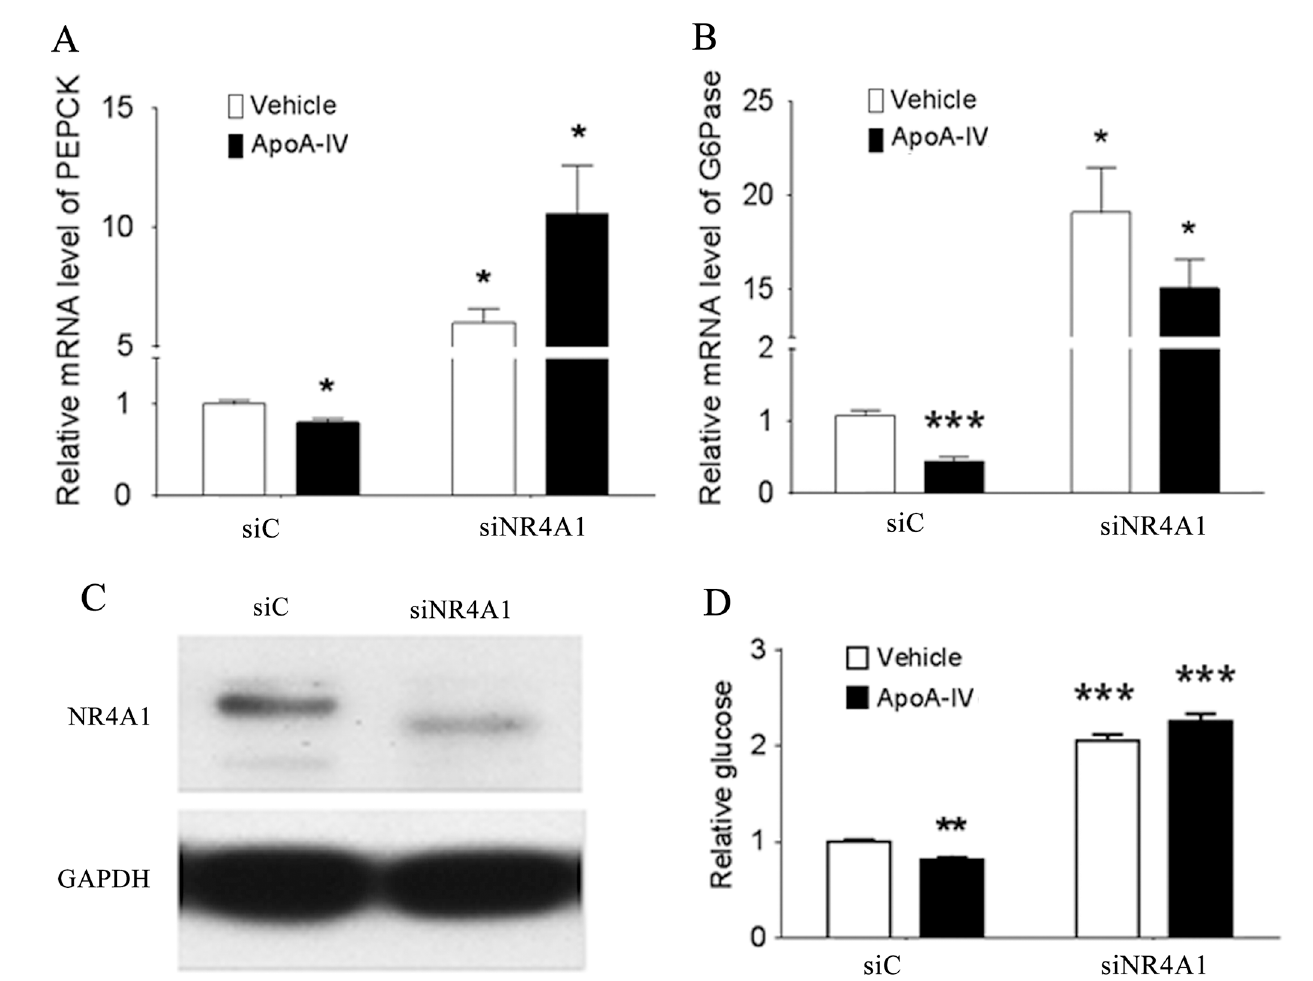
Fig 3. Effect of NR4A1 on ApoA-IV-mediated regulation of G6Pase and PEPCK expression and glucose production. Primary mouse hepatocytes were transfected with siNR4A1 or control siRNA (siC) for 48 h, and treated with 20 μ g/mL r-m-apoA-IV or an equivalent volume of PBS (vehicle control) for 6 h or overnight. The levels of the (A) PEPCK and (B) G6Pase mRNAs were measured by qRT-PCR at 6 h posttreatment. (C) The levels of the NR4A1 and GAPDH (control) proteins were assessed by western blotting to demonstrate the inhibition of NR4A1 protein expression at 6 h posttreatment. (D) The level of glucose in the culture medium was also measured at 24 h posttreatment. Data are presented as the mean ± SE of at least three samples from three independent experiments ( * P < 0.05, ** P < 0.01, and *** P < 0.001 vs. vehicle or siC